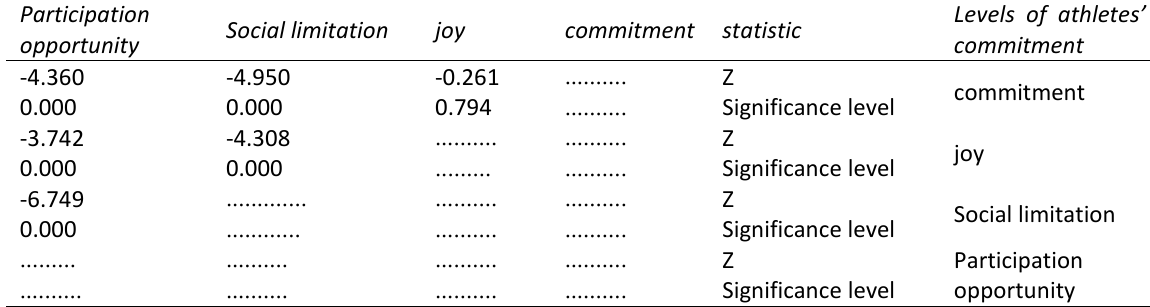
Table 5. Wilcoxon T test results - difference between components of athletes’